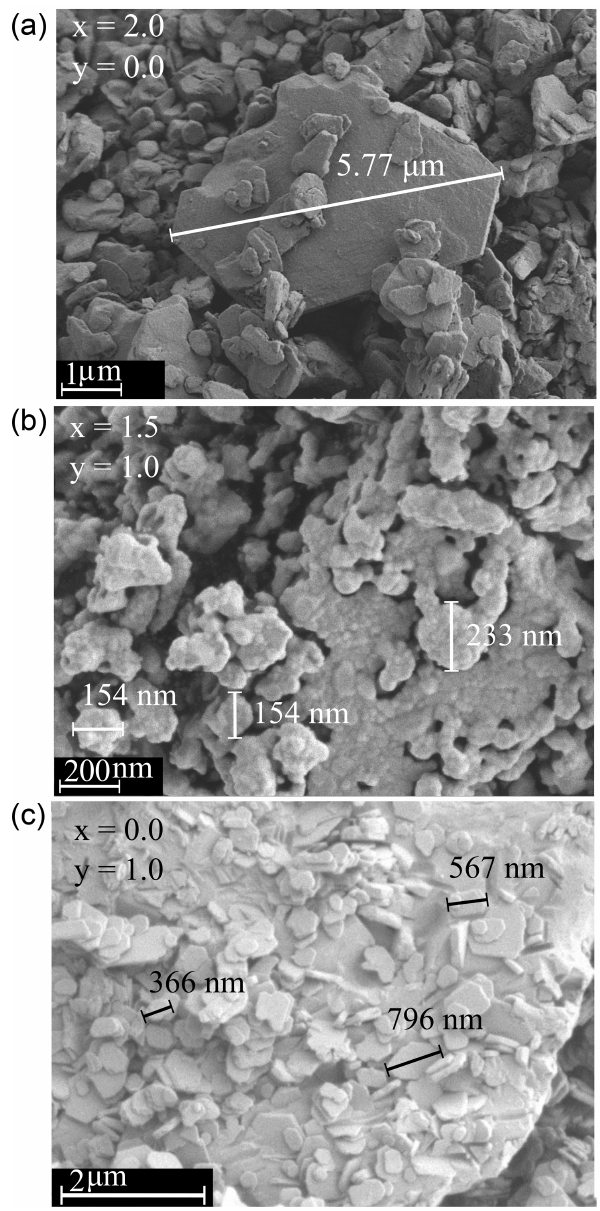
Figure 2. SEM images of three samples ( a : polylithionite, b : trilithionite and c : muscovite). The crystallite sizes decrease with increasing disorder in the